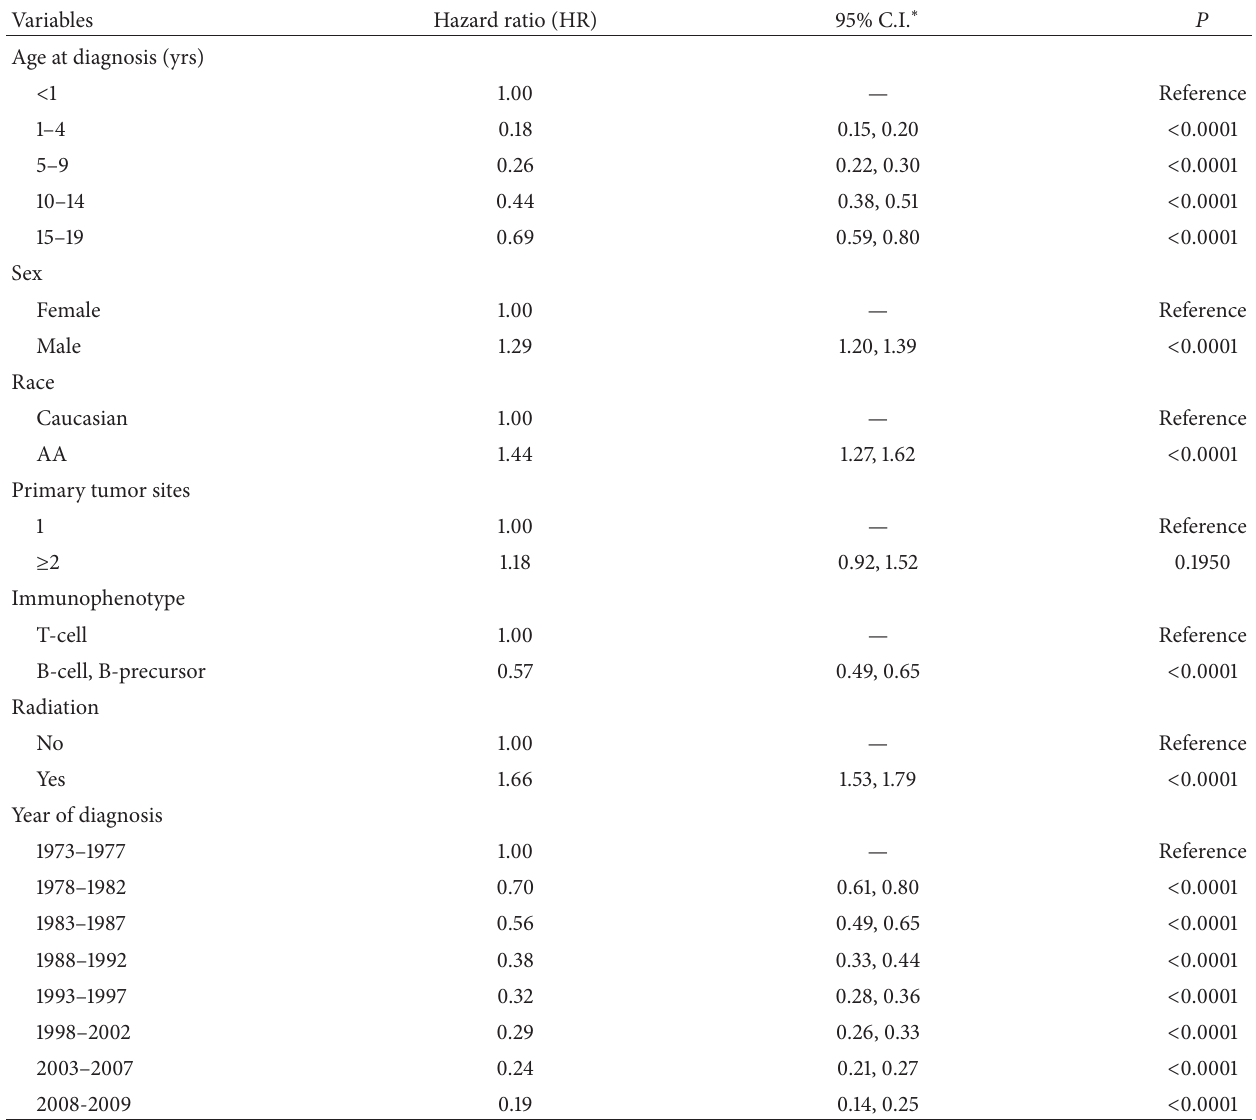
Table 2: Hazard risk of mortality associated with age at diagnosis in pediatric ALL patients (1973–2009 SEER dataset) in an univariable Cox proportional hazard